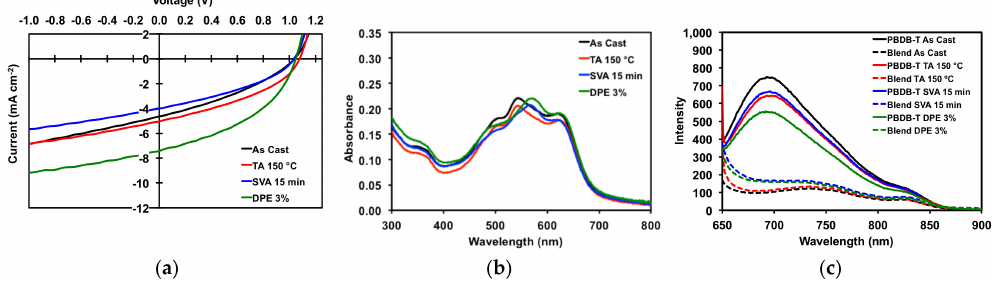
Figure 8. ( a ) JV curves for best devices; ( b ) thin film absorption profiles for 50:50 PBDB-T/ 1 blends; ( c ) thin film emission profiles for pure PBDB-T and 50:50 PBDB-T/ 1 blends. Plots are for devices as cast, TA at 150 ◦ C for 5 min, SVA from o -DCB for 15 min, and with a DPE 3% ( v/v )